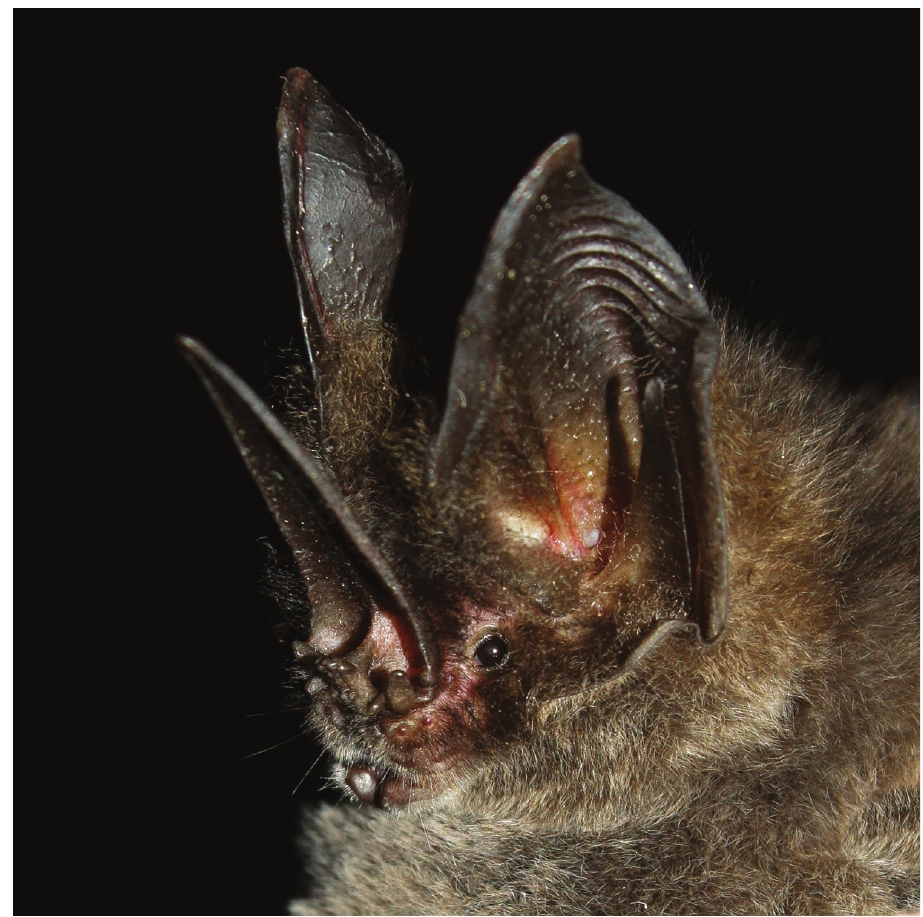
Figure 4. Lonchorhina aurita , Vulnerable species at Brazilian List of Threatened Fauna. Photo: Roberto Leonam Morim